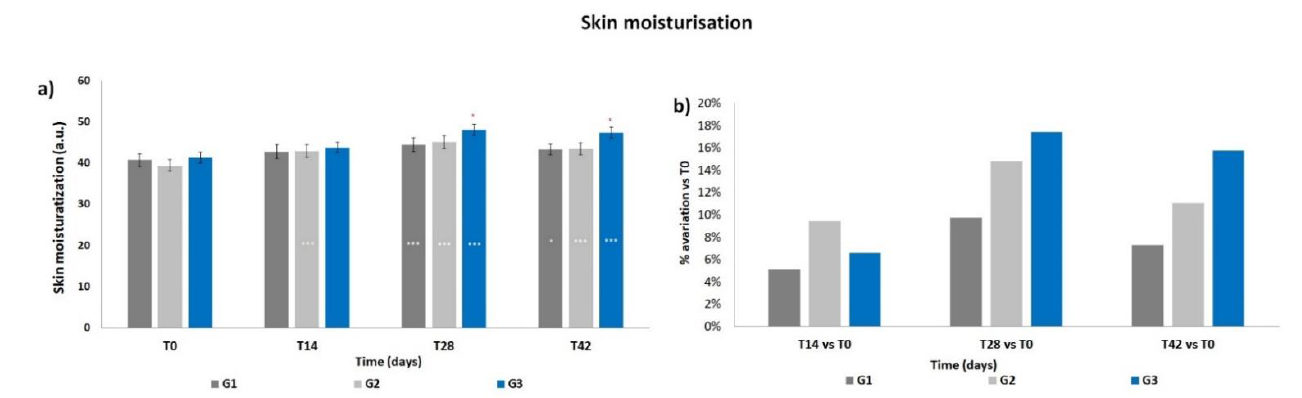
Figure 1. Skin moisturization. The graphs show data obtained at each monitored time for the three groups. ( a ) Data are reported as corneometric arbitrary units (mean ± SEM). ( b ) Data are reported as mean percentage variation with respect to T0. Legend = *** p < 0.001 vs. T0, * p < 0.05 vs. T0, ° p < 0.05 G3 vs.